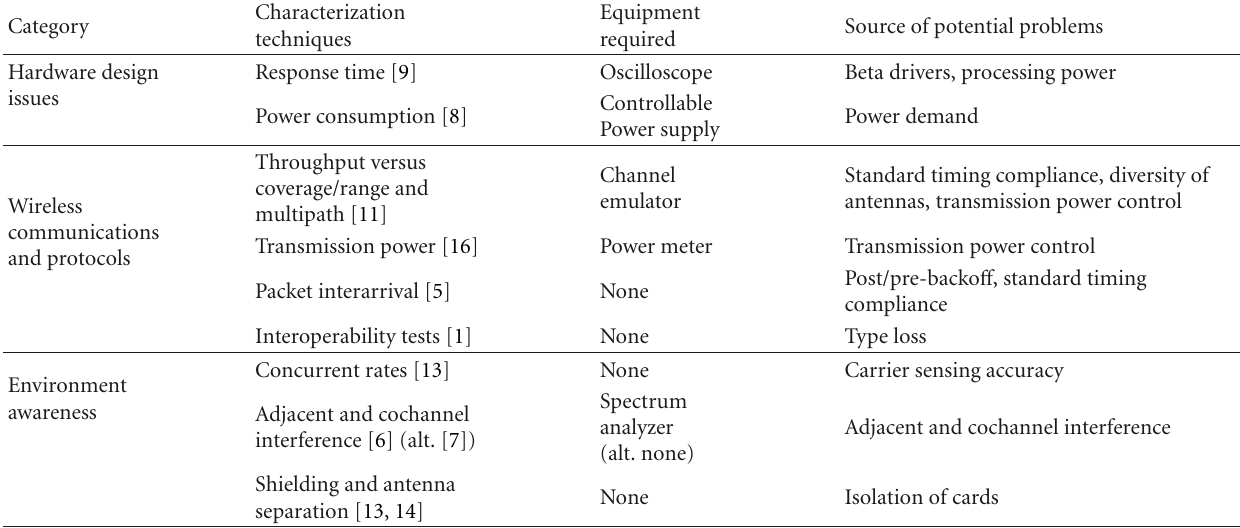
Table 2: Survey of characterization techniques used in the literature to diagnose the origin in the presence of unexpected performance of WLAN